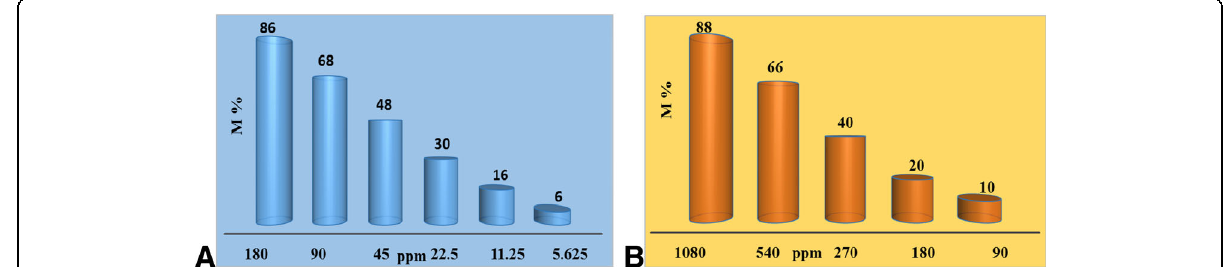
Fig. 8 The mortality percentages of fourth-instar larvae for profenofos to a laboratory and b field strains of Spodoptera littoralis